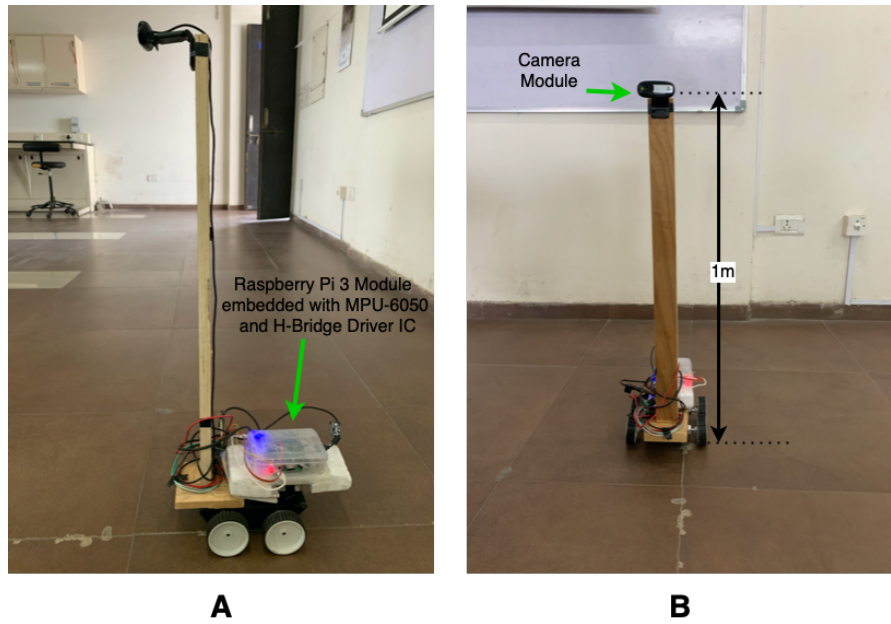
Figure 6. Hardware setup: ( A ) Placement of embedded unit on the robot ( B ) Camera module positioned 1m above the ground level.